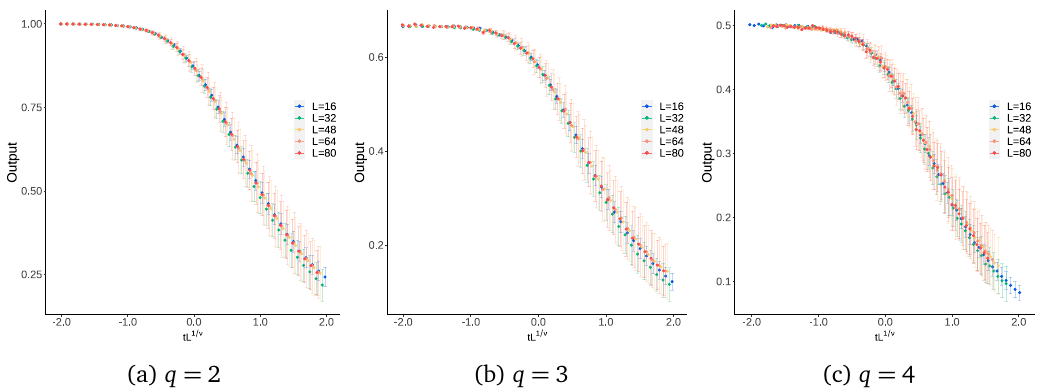
Figure 24: The finite-size scaled plots of the average output of an ensemble of 10 independently trained ANNs – training with simplified data, and testing with MC data of the ferromagnetic q -state Potts model on a honeycomb lattice. The error bars shown are 99.7% confidence intervals of the ensemble average.